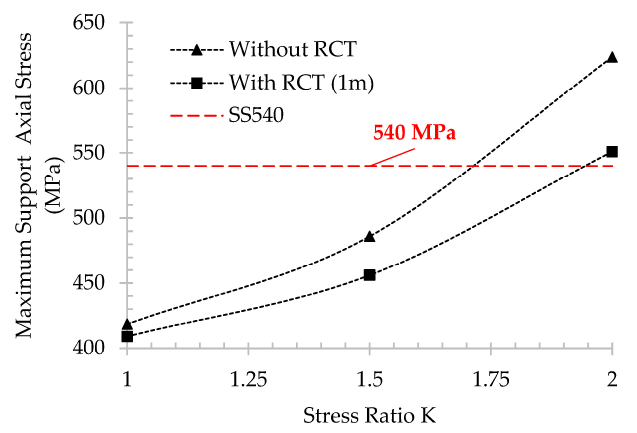
Figure 12. Maximum support axial stress for 100 m of depth (1 m spacing).